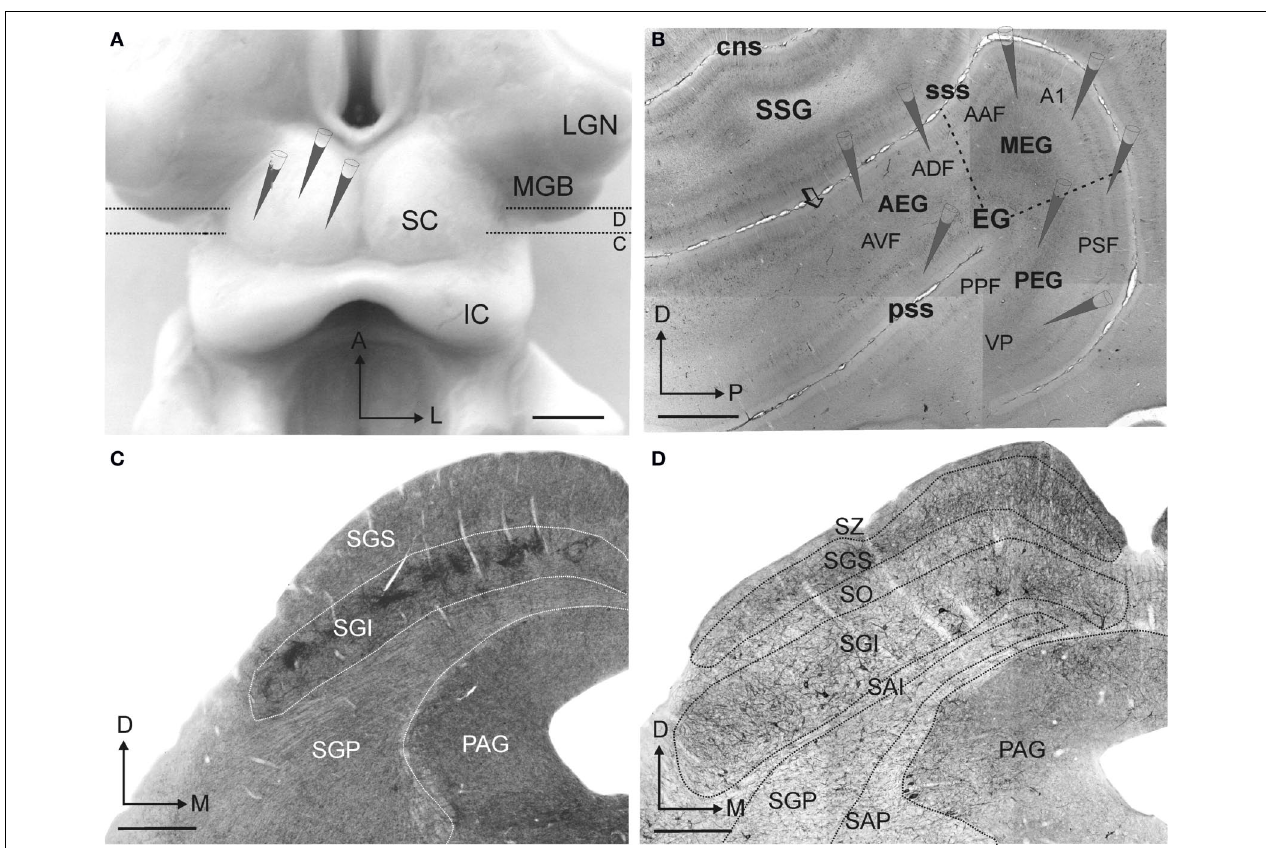
observed. (B) Lateral view at the level of the ectosylvian gyrus taken from a fl attened, tangential section stained with SMI monoclonal antibody. Tracer 32 injections were placed in the different auditory fi elds (see Table 1 ), as indicated. The limits between the different layers in the SC were identifi ed primarily on the basis of acetycholinesterase staining (C) and SMI 32 immunocytochemistry (D) . Calibration bars are 2 mm in (A) and (B) and 0.5 mm in (C) and (D)